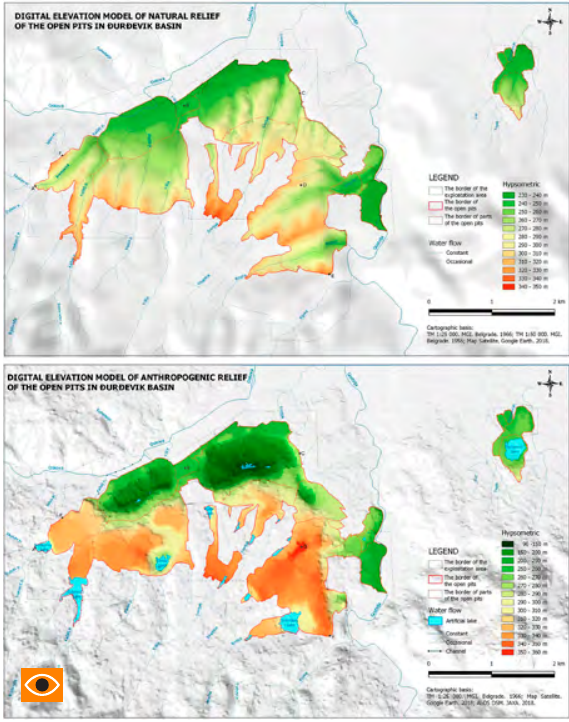
Figure 6. Digital Elevation Model of natural (up) and anthropogenic (down) relief of the study